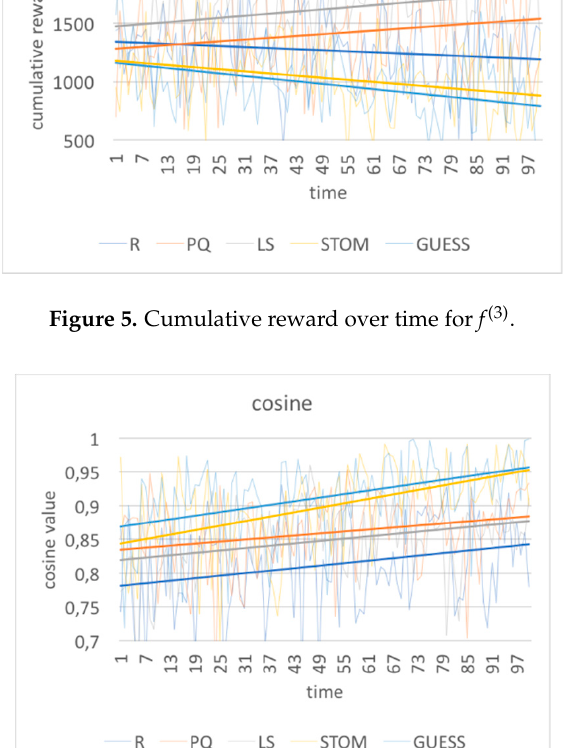
Figure 6. Cosine of the angle between the results and the goal prioritization vector.